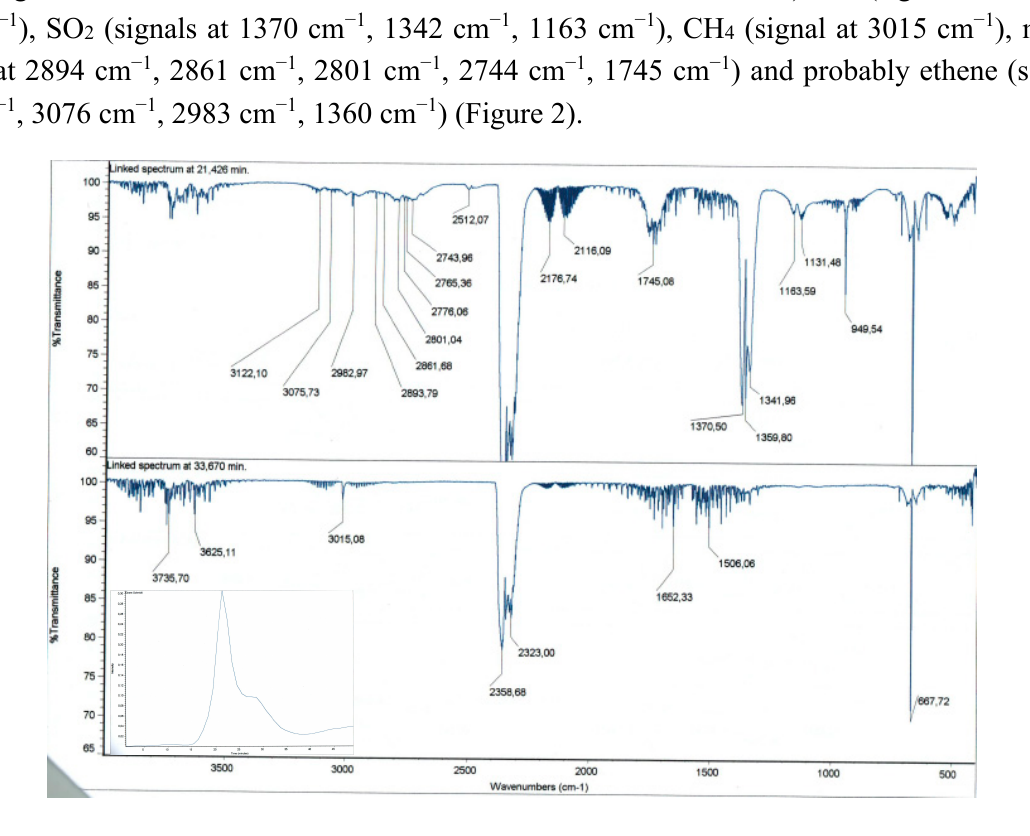
Figure 2. Representative TGA-IR result. Spectra at two single time points 21.4 min and 33.7 min that are shown in the Gram-Schmidt profile